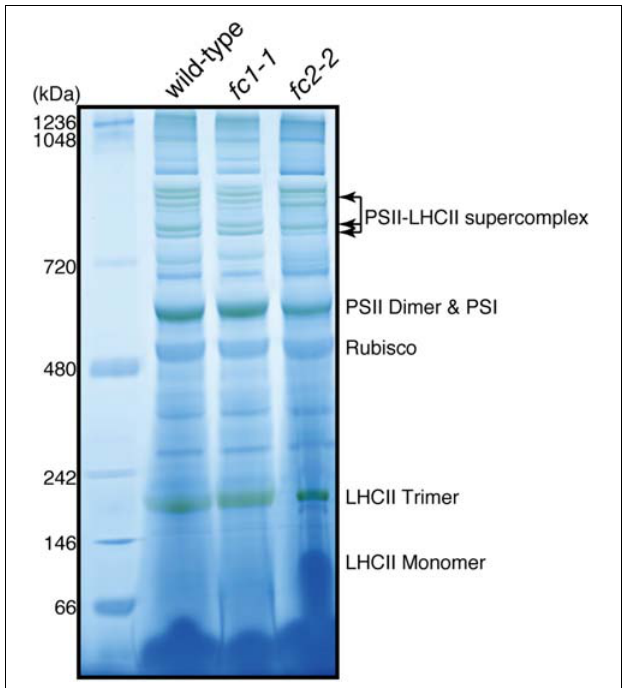
FIGURE 5 | Blue-native PAGE analysis of photosystem complexes in wild-type and ferrochelatase deficient mutants. Thylakoid membrane fractions obtained from 14-day-old seedlings are solubilized. Proteins containing 5 µ g chlorophyll were loaded to 4–14% linear gradient gel. Molecular size markers are indicated on the